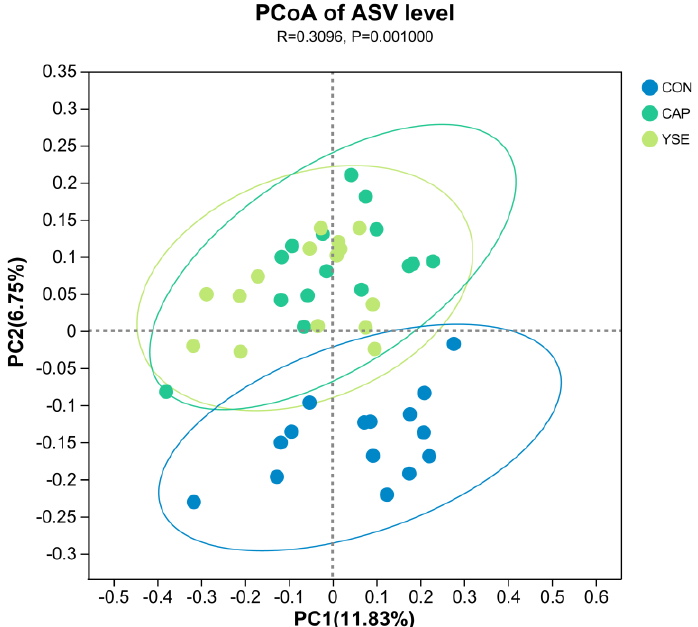
Figure 1. Plot for the principal coordinate analysis. A shorter distance between the sample points denotes greater similarity of the bacteria. CON: control group; CAP: capsaicin group; YSE: yucca schidigera extract